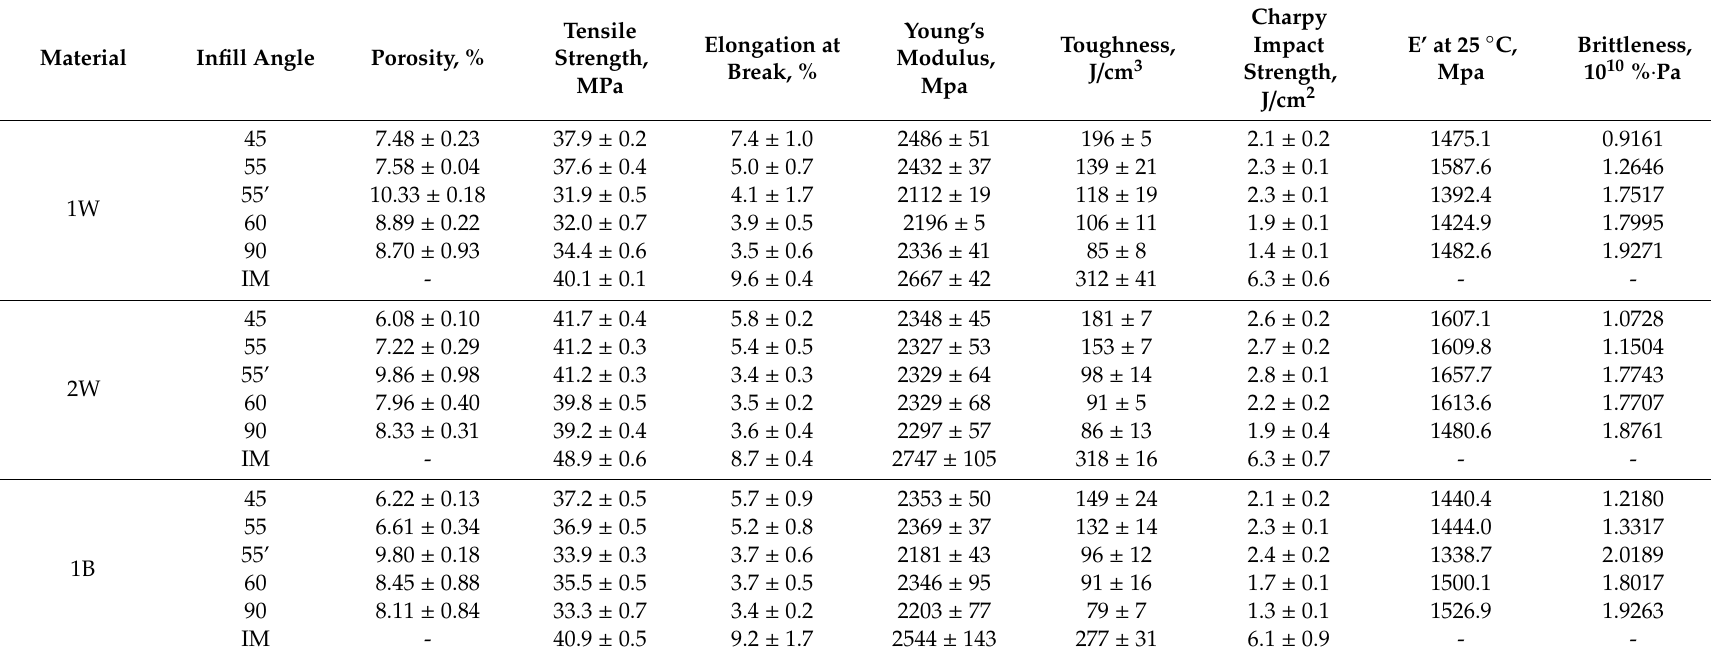
Table 2. Mechanical properties of 3D printed samples depending on used material and infill